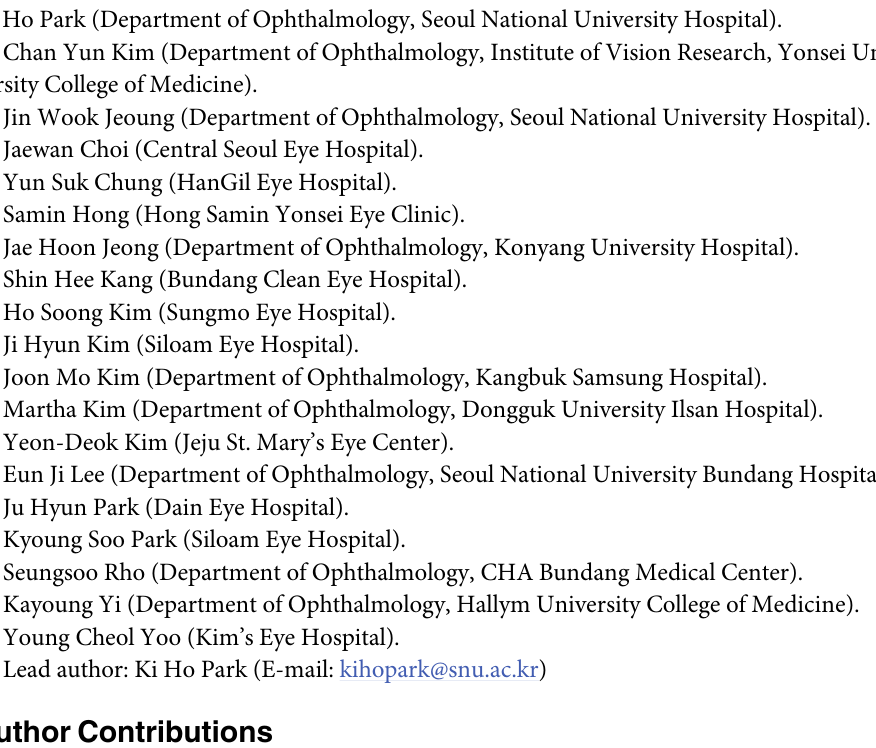
S2 Table. Multivariate regression analysis for systemic and ocular parameters of excluded candidates, using study participants as a